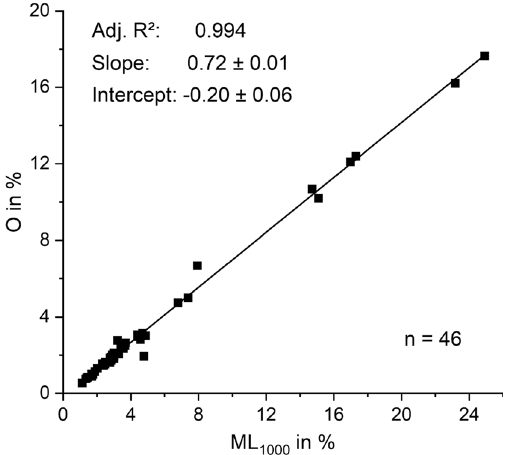
Fig. 4 Linear correlation of the pyrolytic mass loss up to 1000 ◦ C (ML 1000 ) and the oxygen mass content determined by